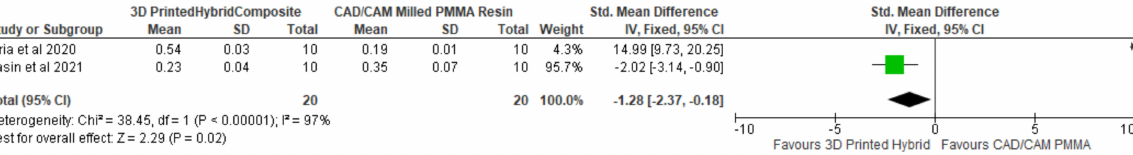
Figure 12. Forest plot comparing surface roughness between 3D-hybrid composite resin and CAD/CAM milled PMMA